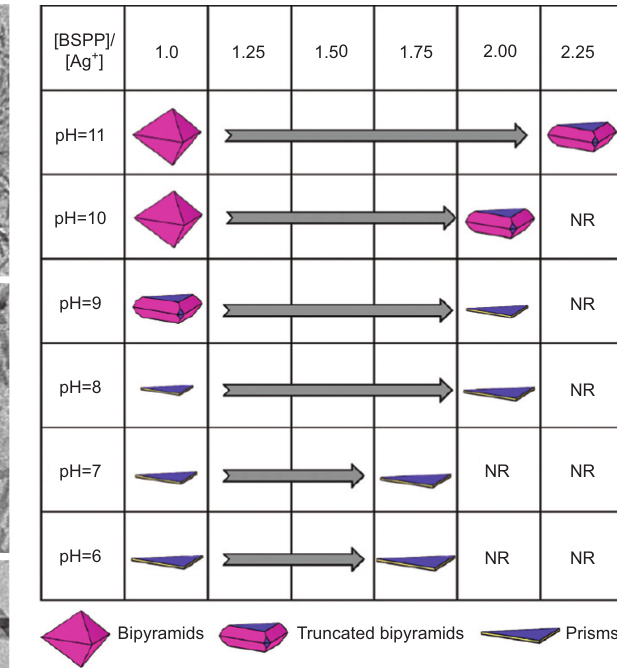
Figure 2 An overview of the effects of pH value and reactant concentration ratios in the photomediated synthesis of shape ani- sotropic silver nanoparticles under the influence of bis( p -sulfonato- phenyl)phenylphosphine